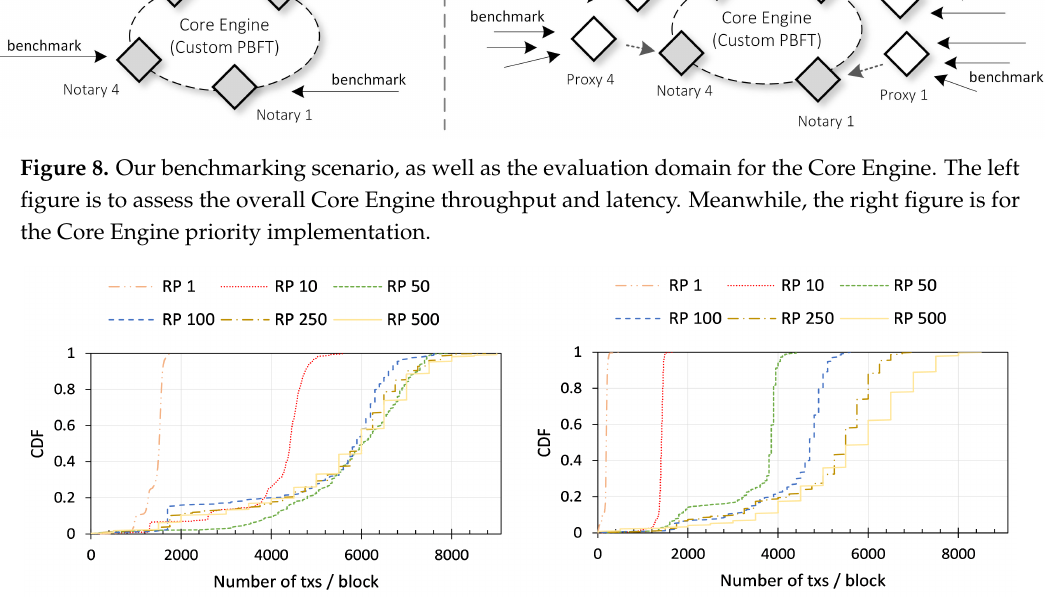
Figure 9. The Cumulative Distribution Function (CDF) for the number of transactions per block in the Core Engine for HMAC ( left ) and EdDSA ( right ) implementation by varying the size of the Request Pool